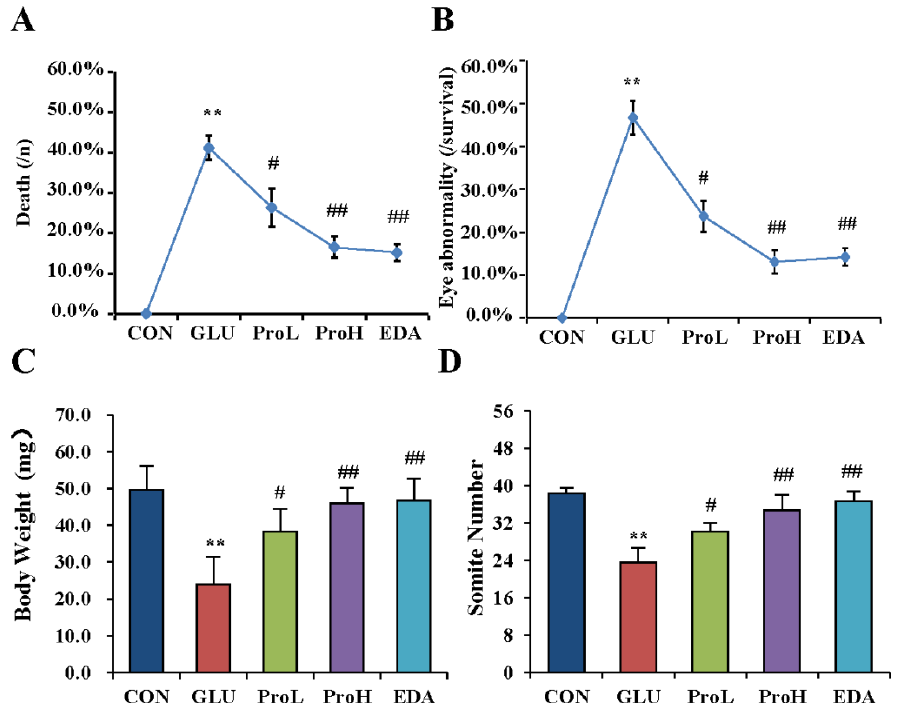
Figure 1. Proanthocyanidins ameliorated high-glucose-induced eye malformation in chick embryo. Death rate ( A ), eye malformation rate ( B ), body weight ( C ) and somite number ( D ) of EDD 3.5 embryos were measured. Morphology images of EDD five embryos. Values were expressed as mean ± SD in each group ( n = 10). ** p < 0.01 vs. control, # p < 0.05, ##